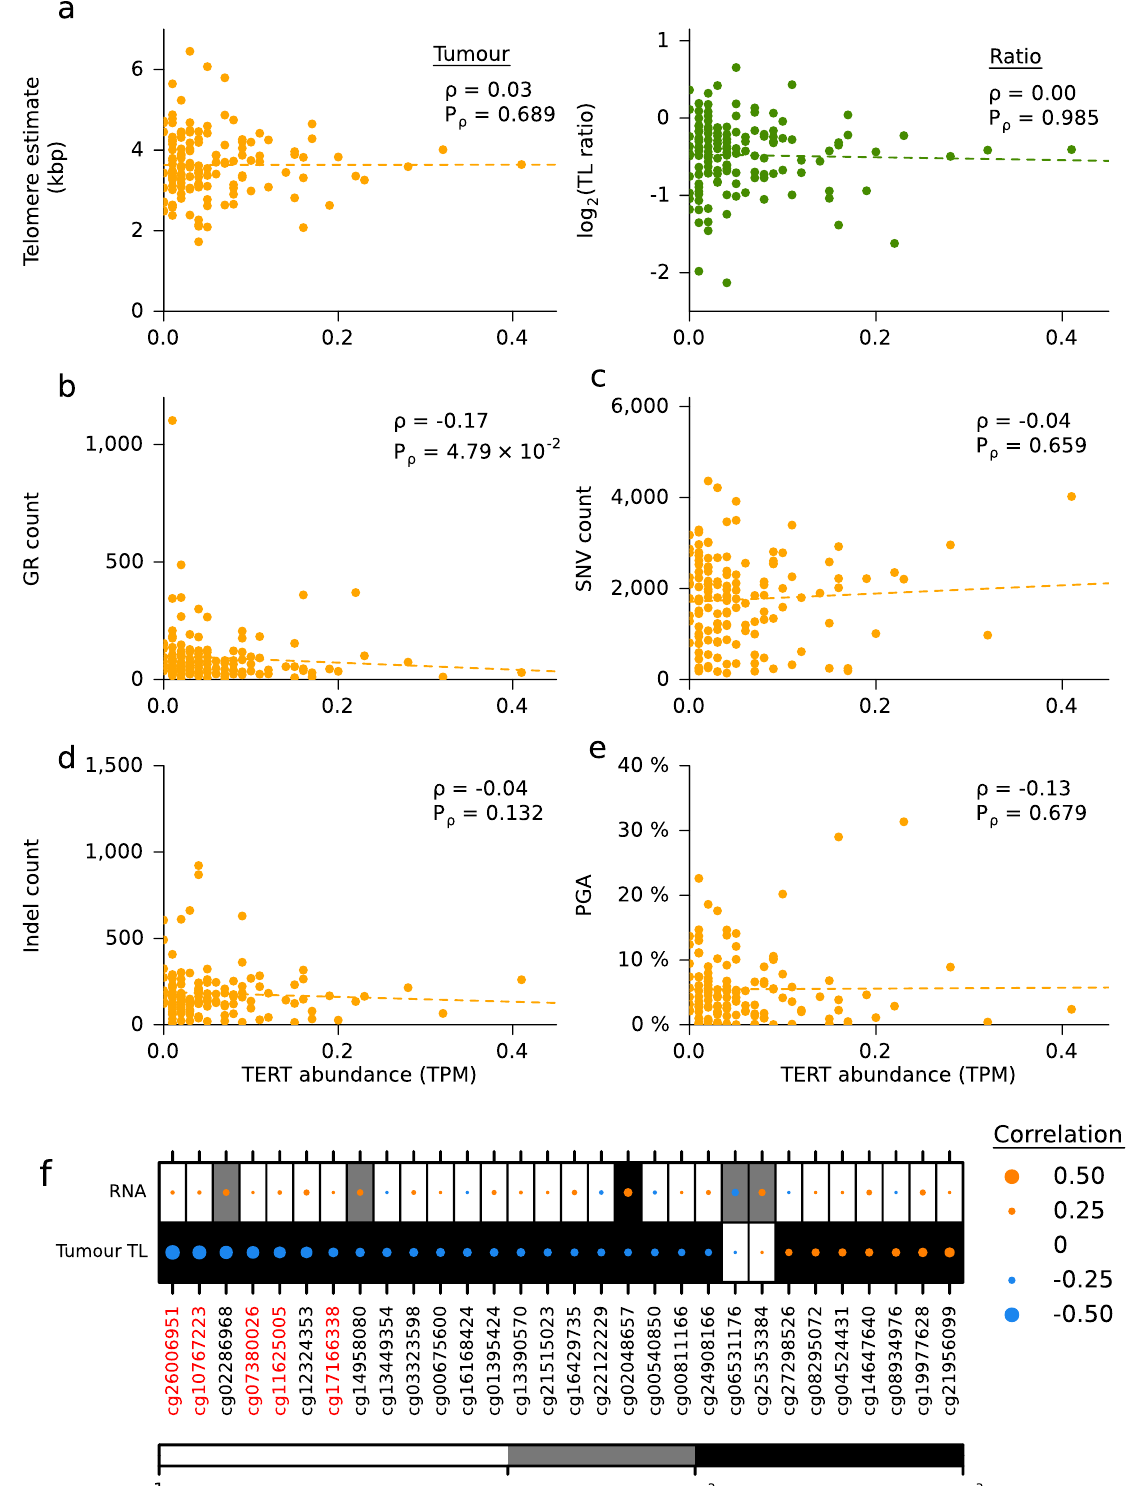
Fig. 3 The genomic correlates of TERT abundance. a Correlation of TERT RNA abundance with tumour telomere length (TL) and TL ratio. Spearman ’ s ρ and P -values are displayed, two-sides. b – e Correlation of TERT abundance and b the number of GRs, c number of SNVs, d number of indels and e PGA. Spearman ’ s ρ and P -values are displayed, two-sided. f Spearman ’ s correlation of signi fi cantly associated methylation probes with RNA abundance and tumour TL. Probes within the promoter are labelled in red while the rest are located in the gene body. Dot size indicated the magnitude of correlation. Background colour indicates unadjusted P -values. Methylation probes are ordered by their correlation between TERT RNA abundance from negative to